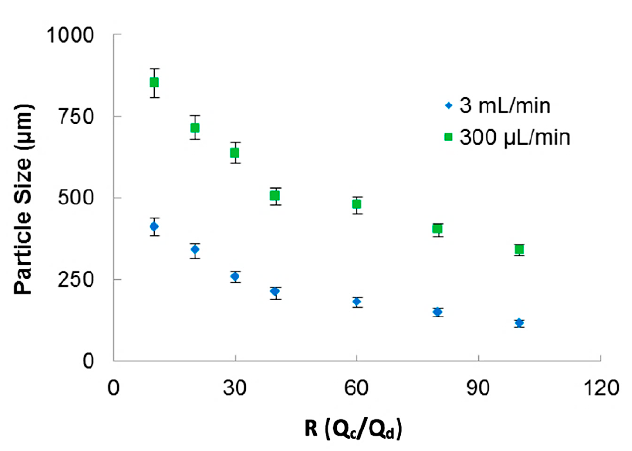
Figure 3. Sodium alginate particle size as a function of the ratio between phases for two different continuous flow rate. Micromachines 2018 , 9 , x FOR PEER REVIEW 7 of 26